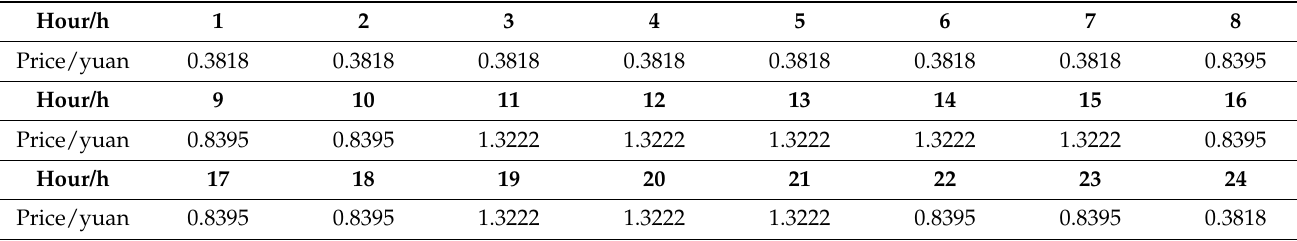
Table A2. Peak and valley electricity price.